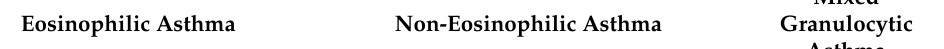
Table 1. Features of major asthma endotypes (modified from